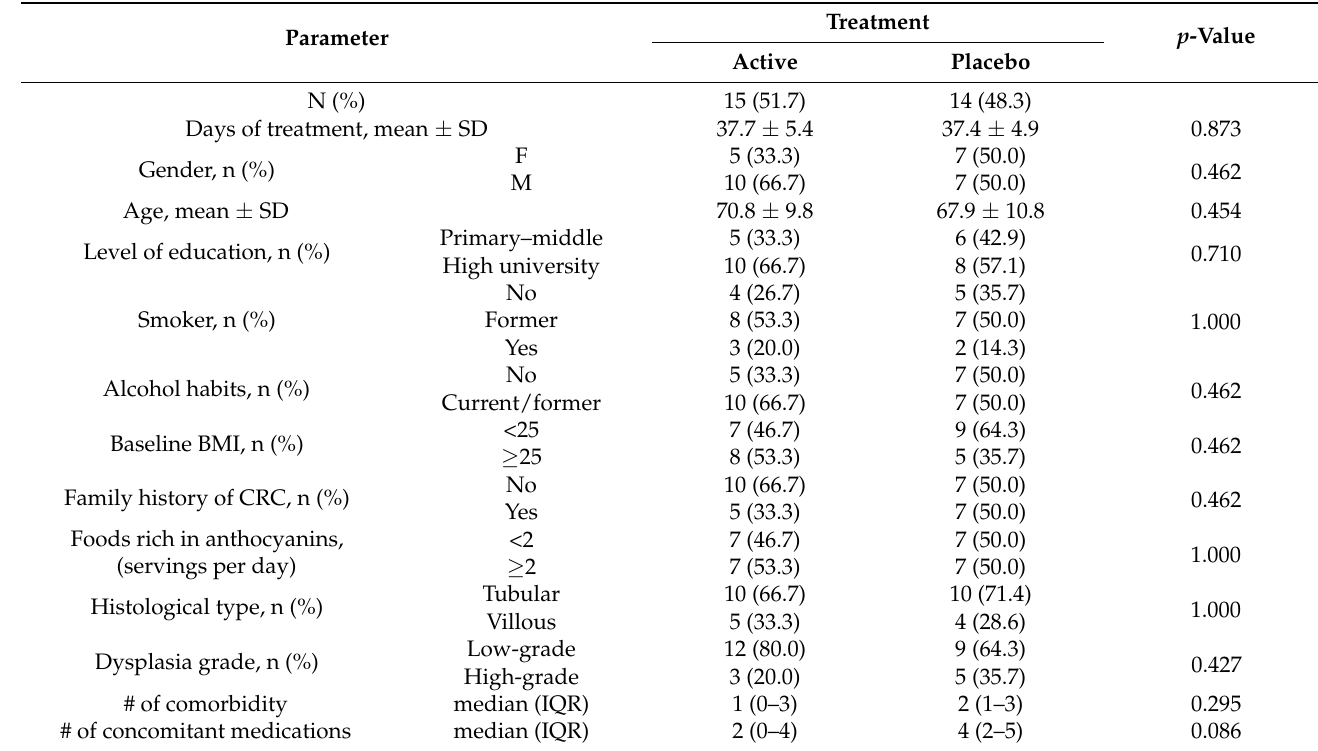
Table 1. Patients’ baseline characteristics by treatment